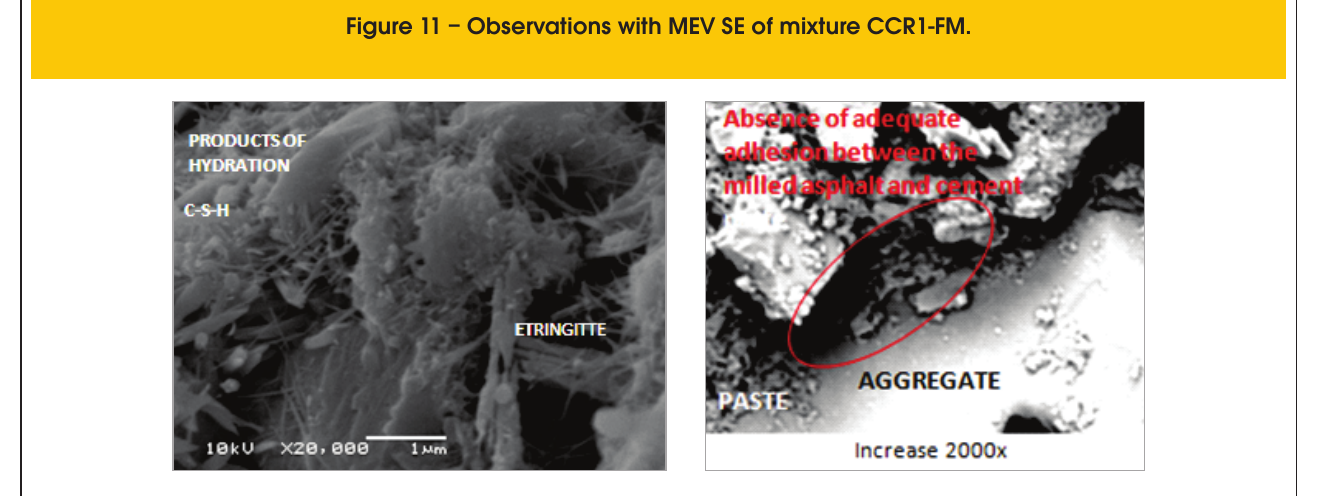
Figure 11 – Observations with MEV SE of mixture CCR1-FM.